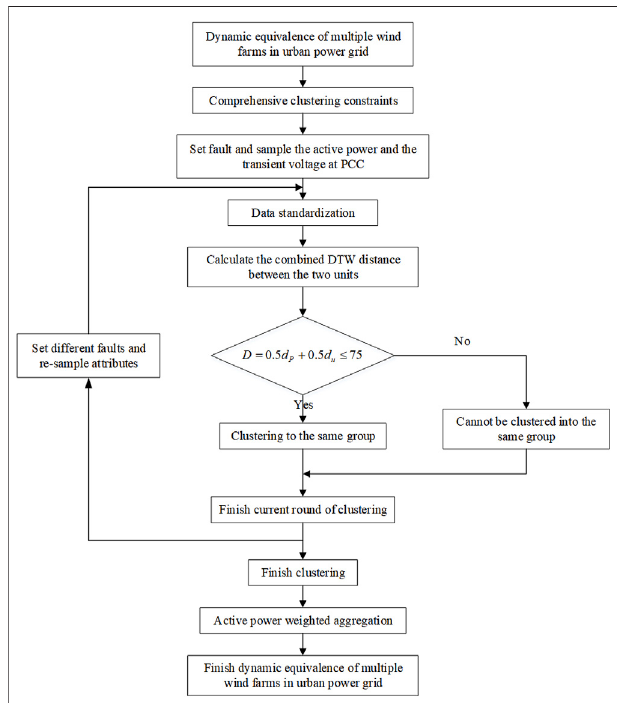
FIGURE 10 | Process fl ow chart of dynamic equivalence among